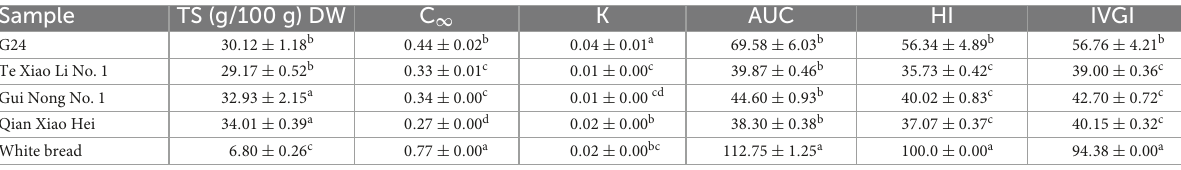
TABLE 4 In vitro glycemic index and involved parameters of adzuki